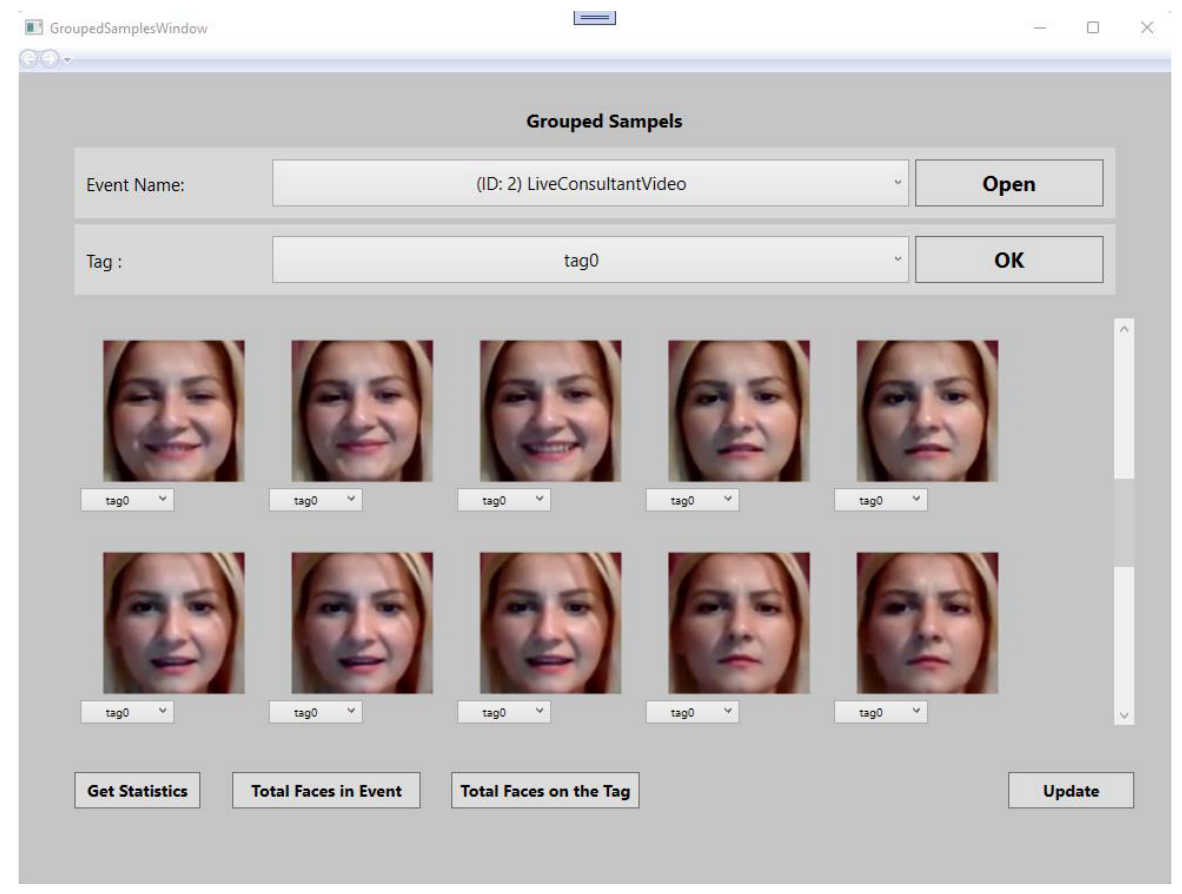
Figure 7. Grouped Samples.